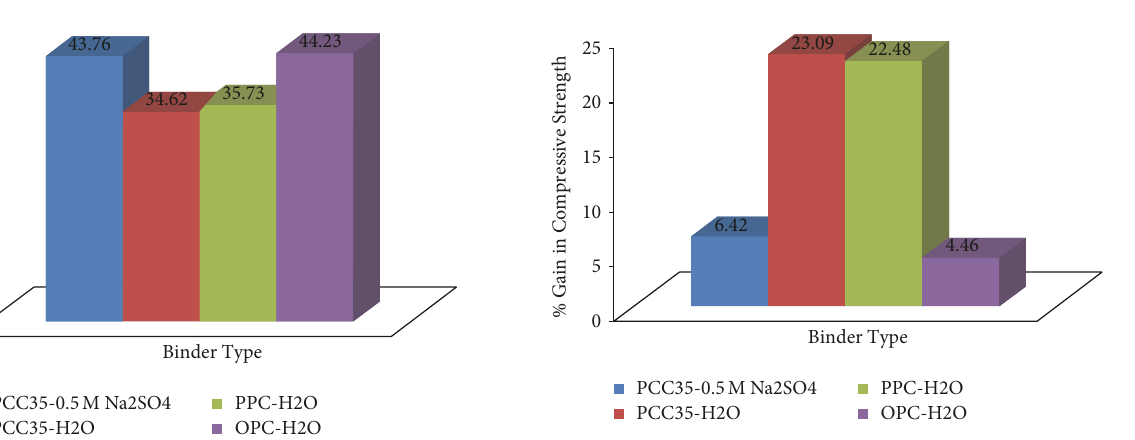
Figure 1: Compressive strength of mortars versus binder type.